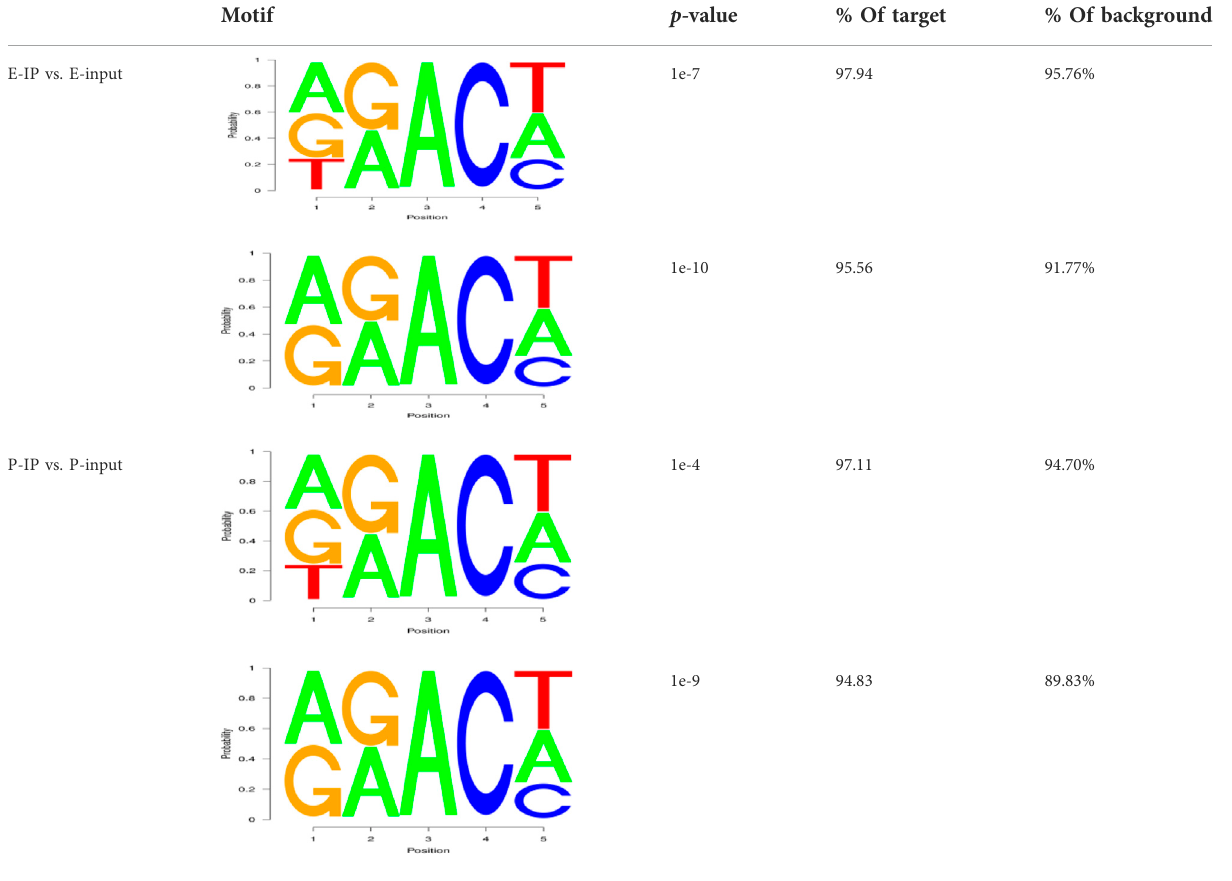
TABLE 2 The motif sequences of m 6 A peaks and their proportions in the two lactation stages.